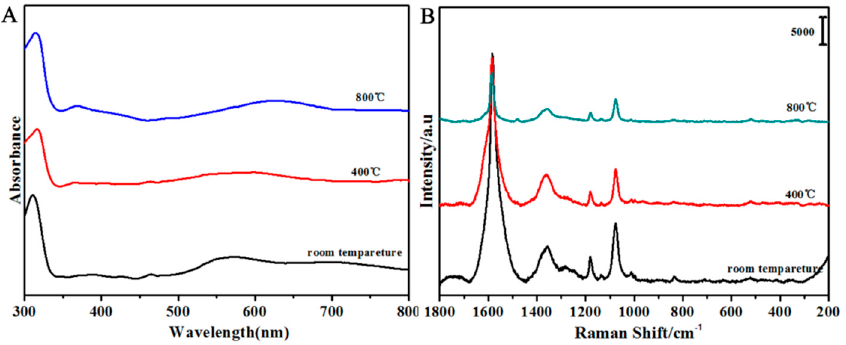
Figure 4. UV-Vis absorbed spectra ( A ) and SERS spectra ( B ) of the SiO 2 /Ag/SiO 2 nanocap arrays at different temperatures.